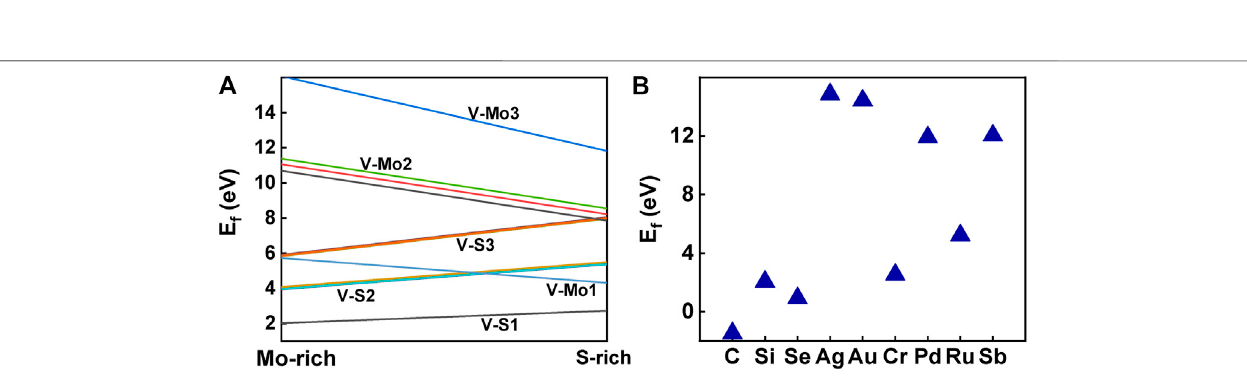
FIGURE 13 | (A) Formation energies of different point defects, plot in Mo-rich and S-rich, which correspond to the chemical potential of its body-centered cubic bulk Mo and the S8 ring, respectively. (B) The doping formation energies of different foreign atoms.